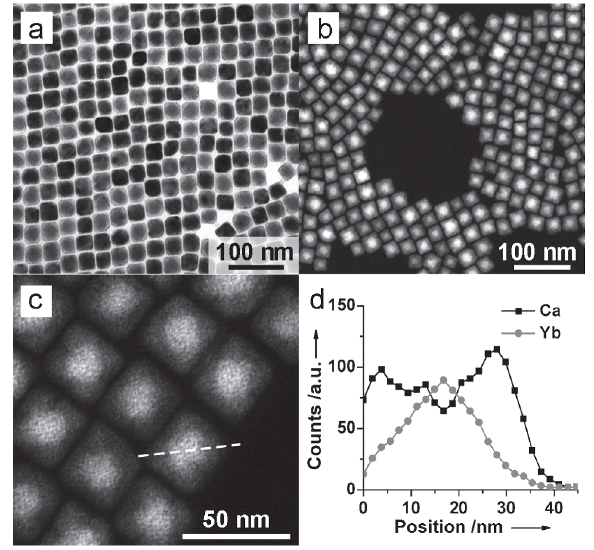
Figure 4. Heteroshell structure of α -NaYbF 4 :Tm@CaF 2 . ( a )TEM, ( b ) high-angle annular dark-field STEM, ( c ) linear EDX scanning of a single UCNP and ( d ) corresponding elemental ratio analysis. Reproduced with permission from [24]. Copyright John Wiley & Sons,